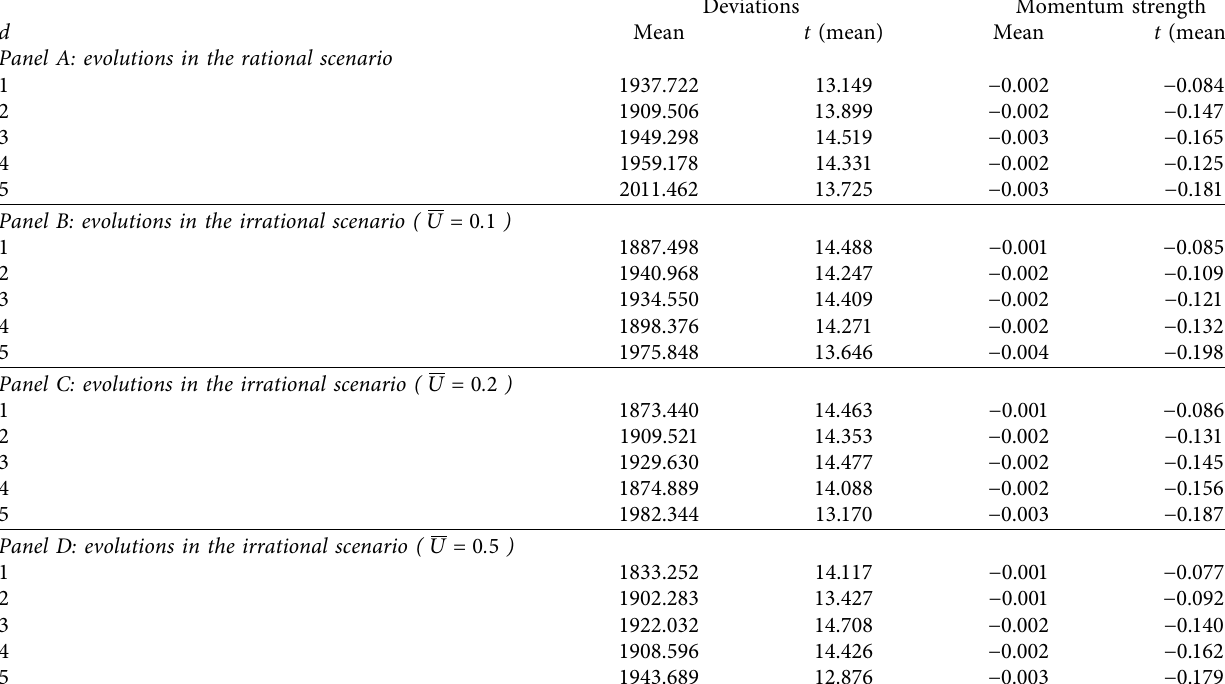
Table 9: Price deviations and momentum strengths after calibration. Note: This table reports the price deviations and momentum strengths after the model parameters are calibrated. In light of Recchioni et al. [124], the initial asset price and initial fundamental price in the calibration are equal to the first weekly observation of the S&P500 in 2021. We calculate the deviations in asset prices from their fun- damentals and momentum strengths for both the rational and irrational scenarios. The magnitude of behavioral hesitation and decision rigidity of the anxious agent is denoted by d . When d equals 1, the anxious agent does not embody hesitation. The anxious agent begins to exhibit hesitation when d equals 2 or is even higher than 2. The upper bounds for the irrational circumstances are 0.1, 0.2, and 0.5,